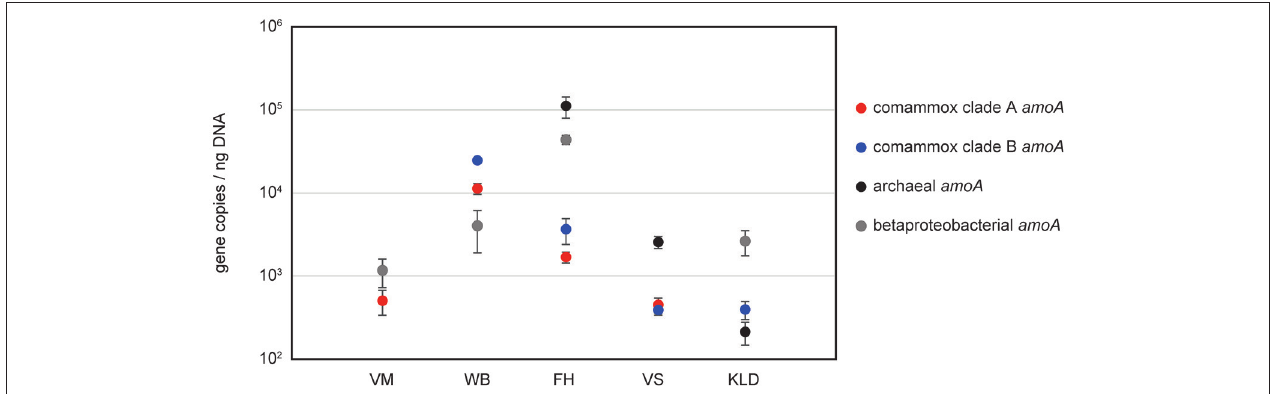
FIGURE 2 | Abundances of amoA genes from comammox Nitrospira , AOA and AOB in selected samples from various environments. VM, WWTP VetMed; WB, GWW Wolfenbüttel; FH, DWTP Friedrichshof; VS, Vercelli rice paddy soil; KLD, Klausen-Leopoldsdorf beech forest soil.